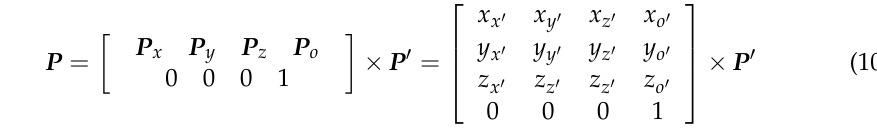
where, z virtual_i and z optimized_i are the Z coordinates of the i th point in the virtual and the optimized point clouds. The distance distributions after optimization are shown in Figure 7, and all distances were lower than 10 nm. The errors of the A-axis and C-axis rotary stage were compen- sated